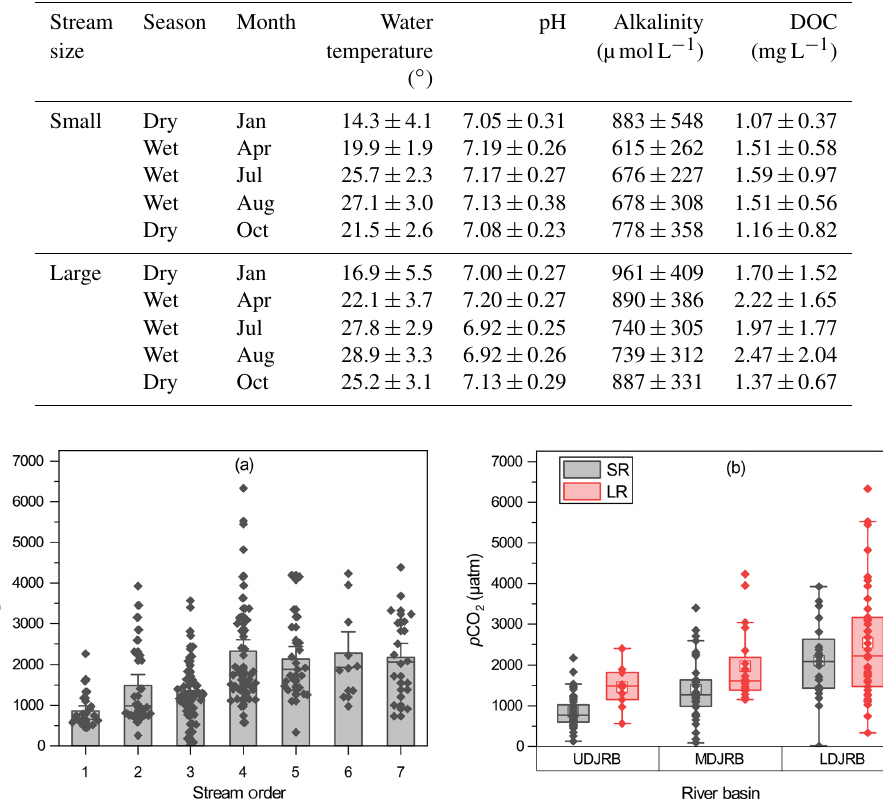
Figure 3. Spatial variations in p CO 2 . (a) Yearly average p CO 2 in the seven stream orders; standard errors (SE) are displayed by error bars. (b) Measured p CO 2 in small and large rivers among three regions in the DJRB. The box mid-lines represent medians; the interquartile range (IQR) is represented by the top and bottom of the box, respectively; whiskers indicate the range of 1.5 IQR; the white square symbols represent means, and the other symbols represent p CO 2 values for each sampled